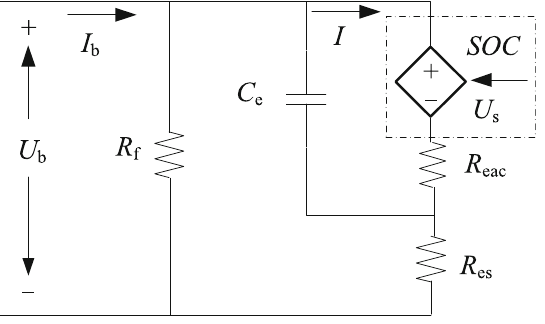
Fig. 1 Equivalent circuit model of